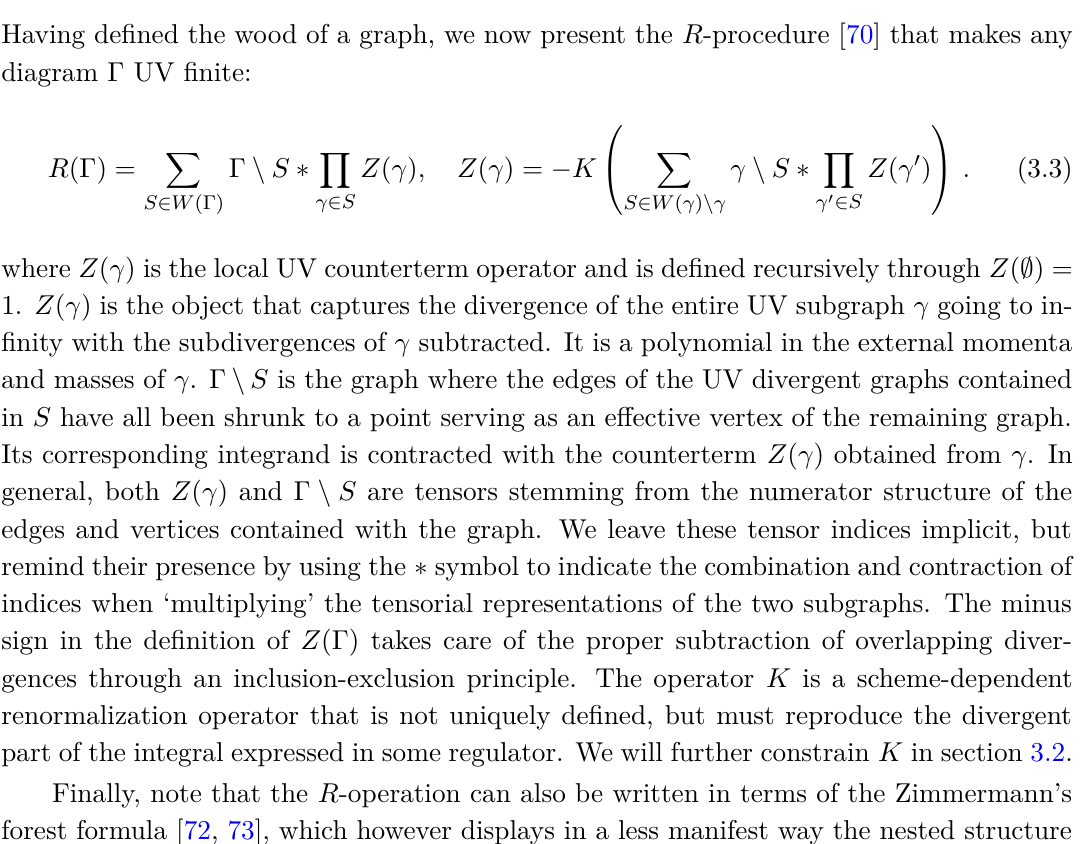
, with dod’s being 1 , 0 , 0 , 0 , 2 and 0